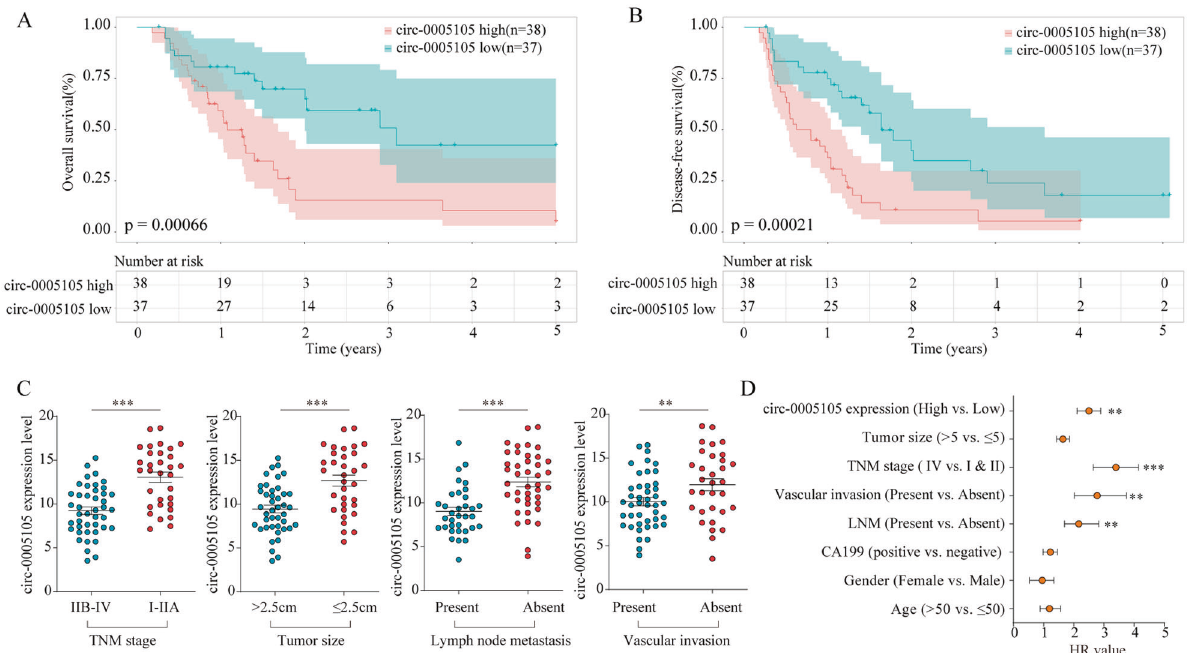
Fig. 2 Upregulated circ-0005105 was positively correlated with poor prognosis of PDAC. Patients with higher circ-0005105 expression had a shorter overall survival time ( A ) and disease-free survival time ( B ) than those with lower circ-0005105 expression. C The correlation between the expression of circ-0005105 and TNM stage, tumor size, lymph node metastasis, and vascular invasion of PDAC patients. D The multivariate Cox regression analyses were performed to depict the correlations between the indicated clinical criteria and circ-0005105 expression level. ** P < 0.01, *** P <